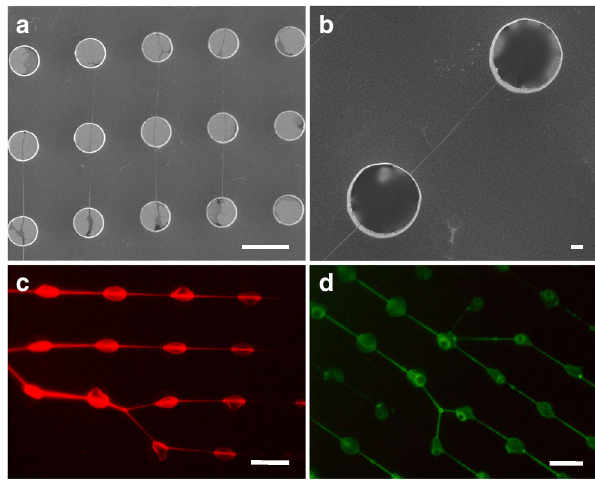
Fig. 1 SEM and fl uorescence microscope images of intercalated DNA. After the complete evaporation of the solvent ( a ), DNA bundles can be imaged by SEM: they are homogeneously suspended and distributed between silicon micro-pillars. In ( b ), a particular of a suspended DNA bundle, covering the pillar – pillar distance of 12 μ m. DNA/intercalator optical images acquired using an excitation of ( c ) 540/25 nm (DM 565, BA 605/55) for the GelRed evaluation and of ( d ) 465 – 495 nm as in the case of YOYO-1. The scale bars correspond to 10 μ m, except for ( b ) which corresponds to 1 μ